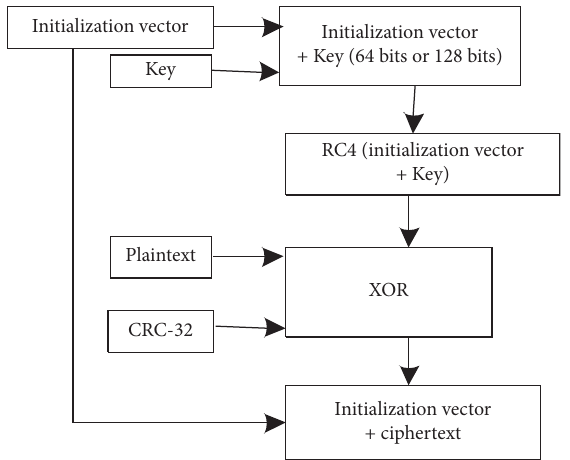
Figure 2: WEP encryption